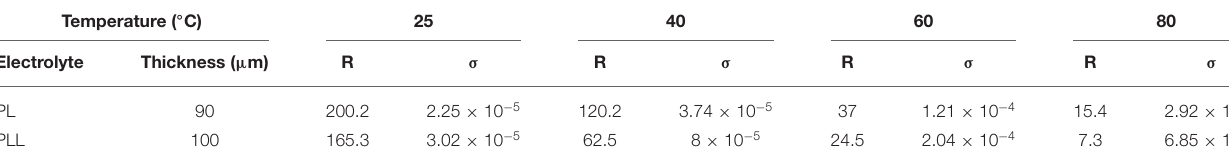
TABLE 1 | Resistance and ionic conductivities of the PL and PLL electrolytes at different temperatures. Temperature ( ◦ C)